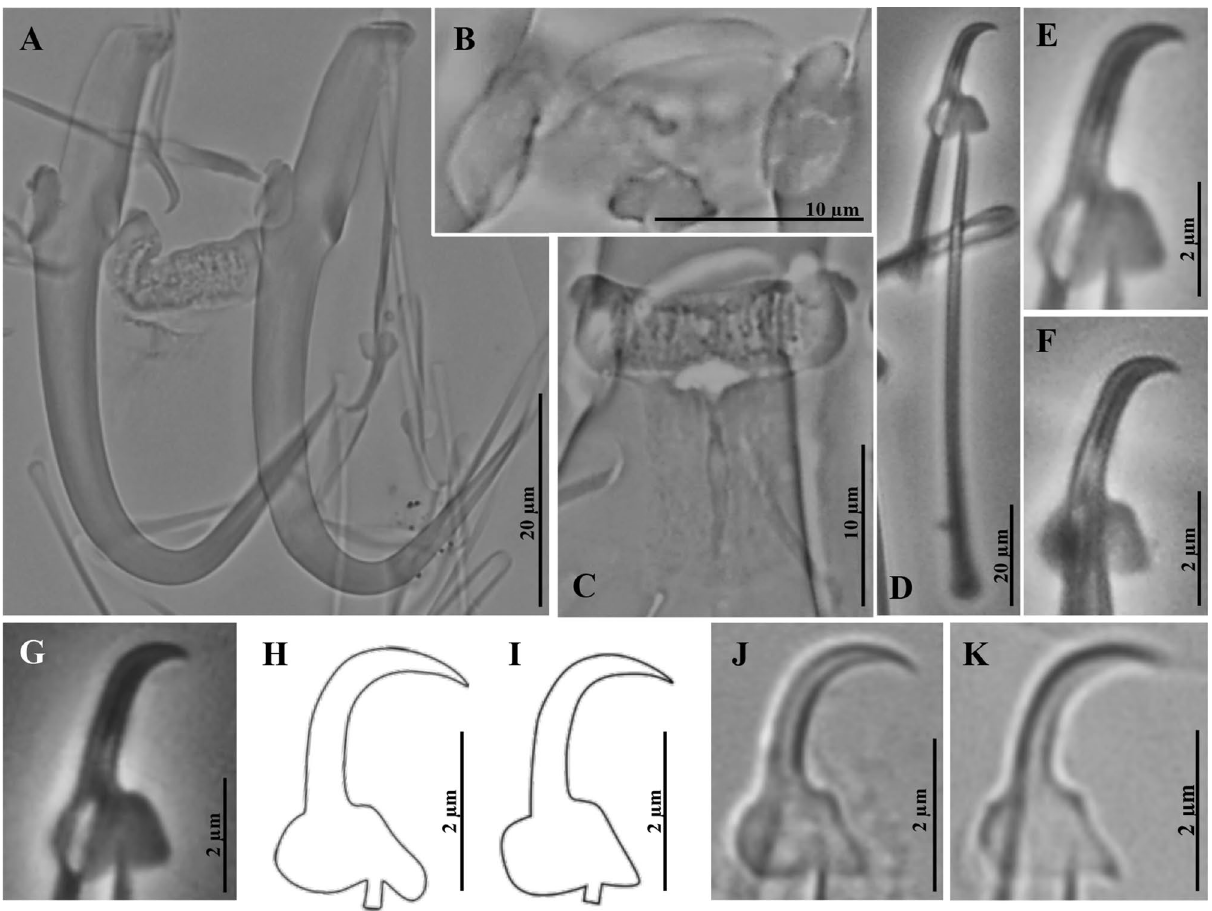
Figure 3. Micrographs of Gyrodactylus shinni n. sp. described from Oreochromis niloticus from Chiapas, Mexico; and comparison of marginal hook sickles to those of Gyrodactylus species found in cichlids with similar morphologies. ( A ) Hamuli complex. ( B ) Dorsal bar. ( C ) Ventral bar. ( D ) Marginal hook at a glance. ( E , F ) Marginal hook sickle. ( G ) Marginal hook sickles of G. shinni n. sp. compared with those of: ( H ) G. occupatus Zahrandníčková, Barson, Luus-Powell and Přikrylová, 2016 (re-examination; new drawing based on microphotograph kindly provided by Dr. Ivá Přikrylová). ( I ) G. parisellei Zahrandníčková, Barson, Luus-Powell and Přikrylová, 2016 (re-examination; new drawing based on microphotograph kindly provided by Dr. Ivá Přikrylová). ( J ) G. ulinganisus García-Vásquez, Hansen, Christison, Bron and Shinn, 2011. ( K ) G. cichlidarum (García-Vásquez, Hansen and Shinn,